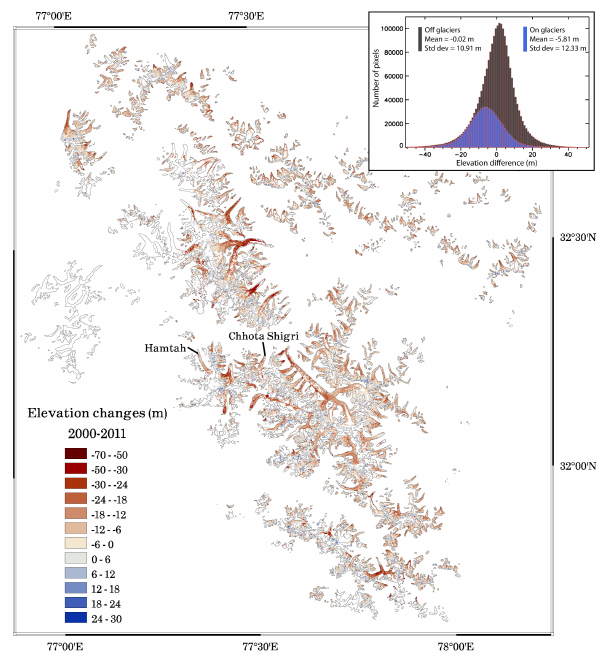
Fig. 4. Map of elevation changes between February 2000 and Oc- tober 2011 for 2110km 2 of glaciers in the Lahaul and Spiti region. The inset shows the distribution, mean and standard deviation of the elevation changes on/off glaciers. The map of elevation changes off glaciers is shown as Appendix (Fig. A1).